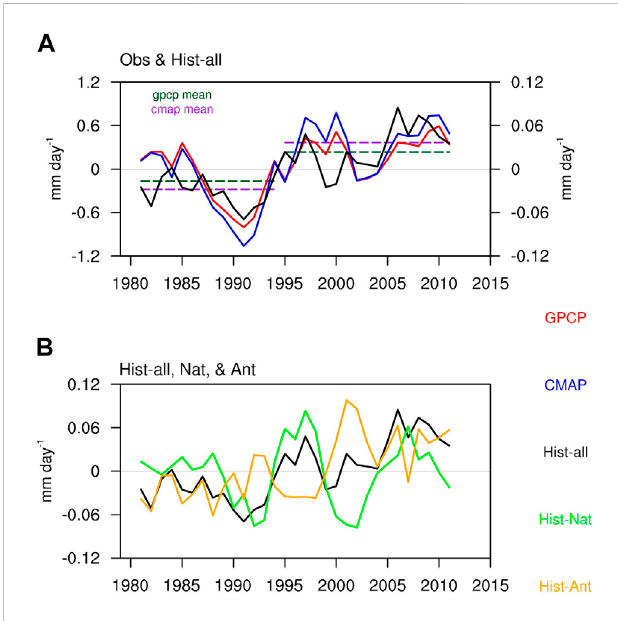
FIGURE 6 The 5-year running mean of the winter precipitation anomalies (unit: mm day − 1 ) averaged over Southeast Asia (10 ° S – 20 ° N, 90 ° – 140 ° E) during 1979 – 2014. (A) GPCP (left y -axis), CMAP (left y -axis), and Hist-all MME(right y -axis)areindicatedbythered,blue,andblacklines,and (B) Hist-Nat (left y -axis) and Hist-Ant (left y -axis) MME are indicated by the green and orange lines, respectively. The dashed dark-green and purple lines in (A) denote the mean value of precipitation anomalies during 1979 – 1994 and 1995 – 2013 for GPCP and CMAP,